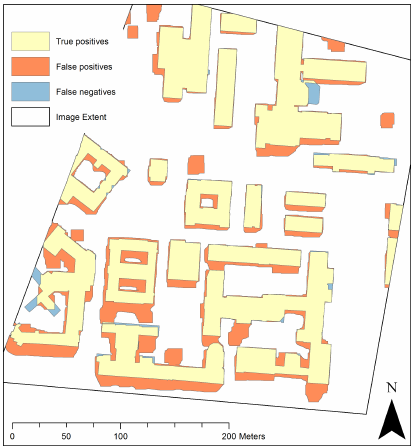
Figure 7: Detection results after thresholding the nDSM and ap- plying a morphological filter